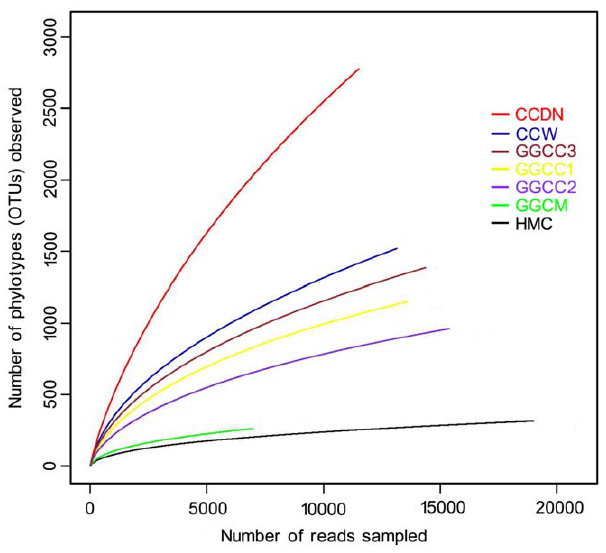
Figure 1. Rarefaction analysis of the different samples. Rarefaction curves of OTUs clustered at 97% sequence identity